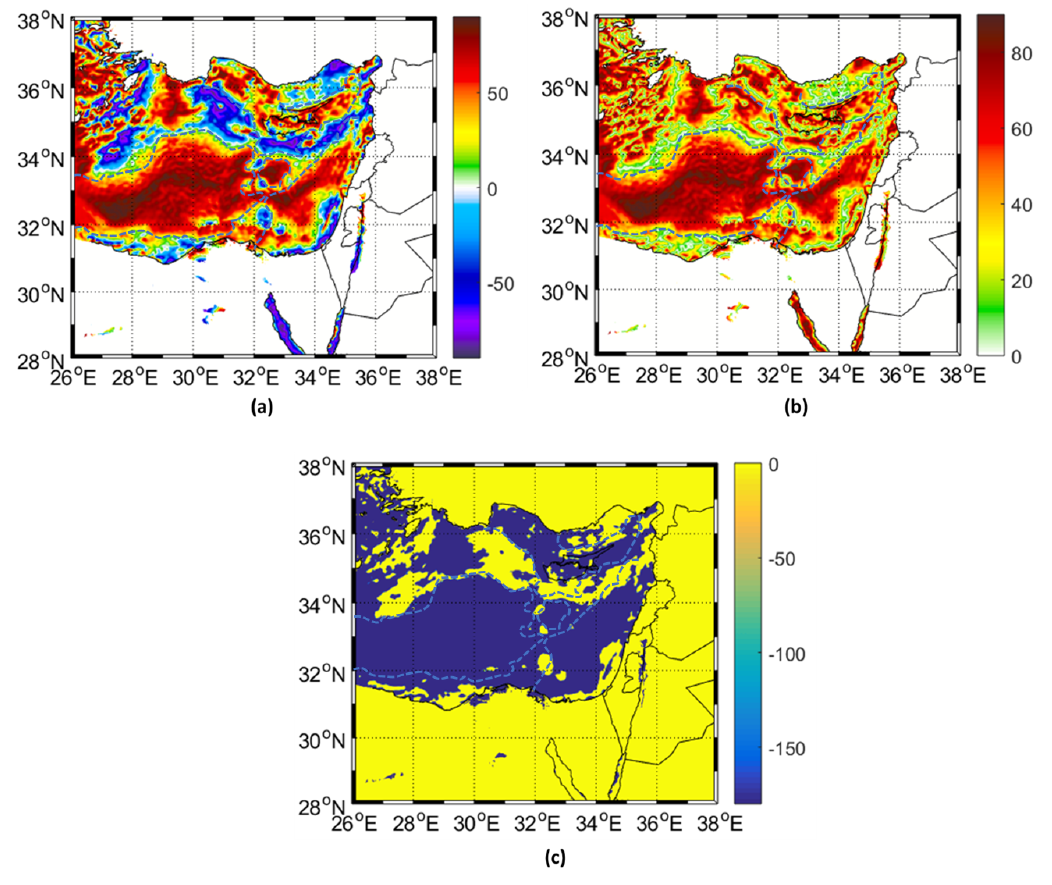
Figure 6. The tilt angle ( a ), theta angle ( b ) and their correlation angle ( c ). A mask has been applied onshore; unit (degree). Dashed blue lines represent the boundary of the main geological